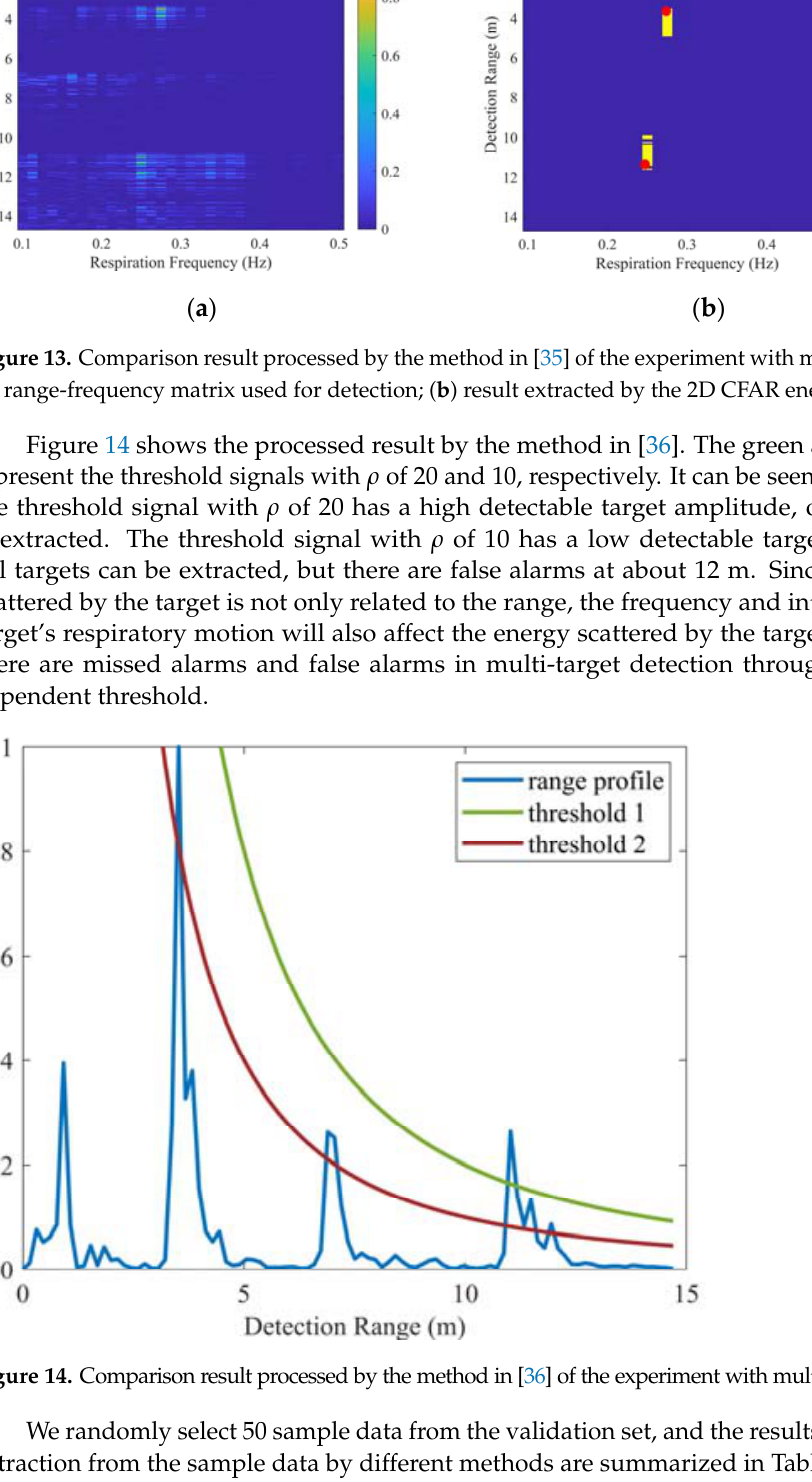
Figure 13. Comparison result processed by the method in [35] of the experiment with multiple tar ‐ gets: ( a ) range ‐ frequency matrix used for detection; ( b ) result extracted by the 2D CFAR energy windows.